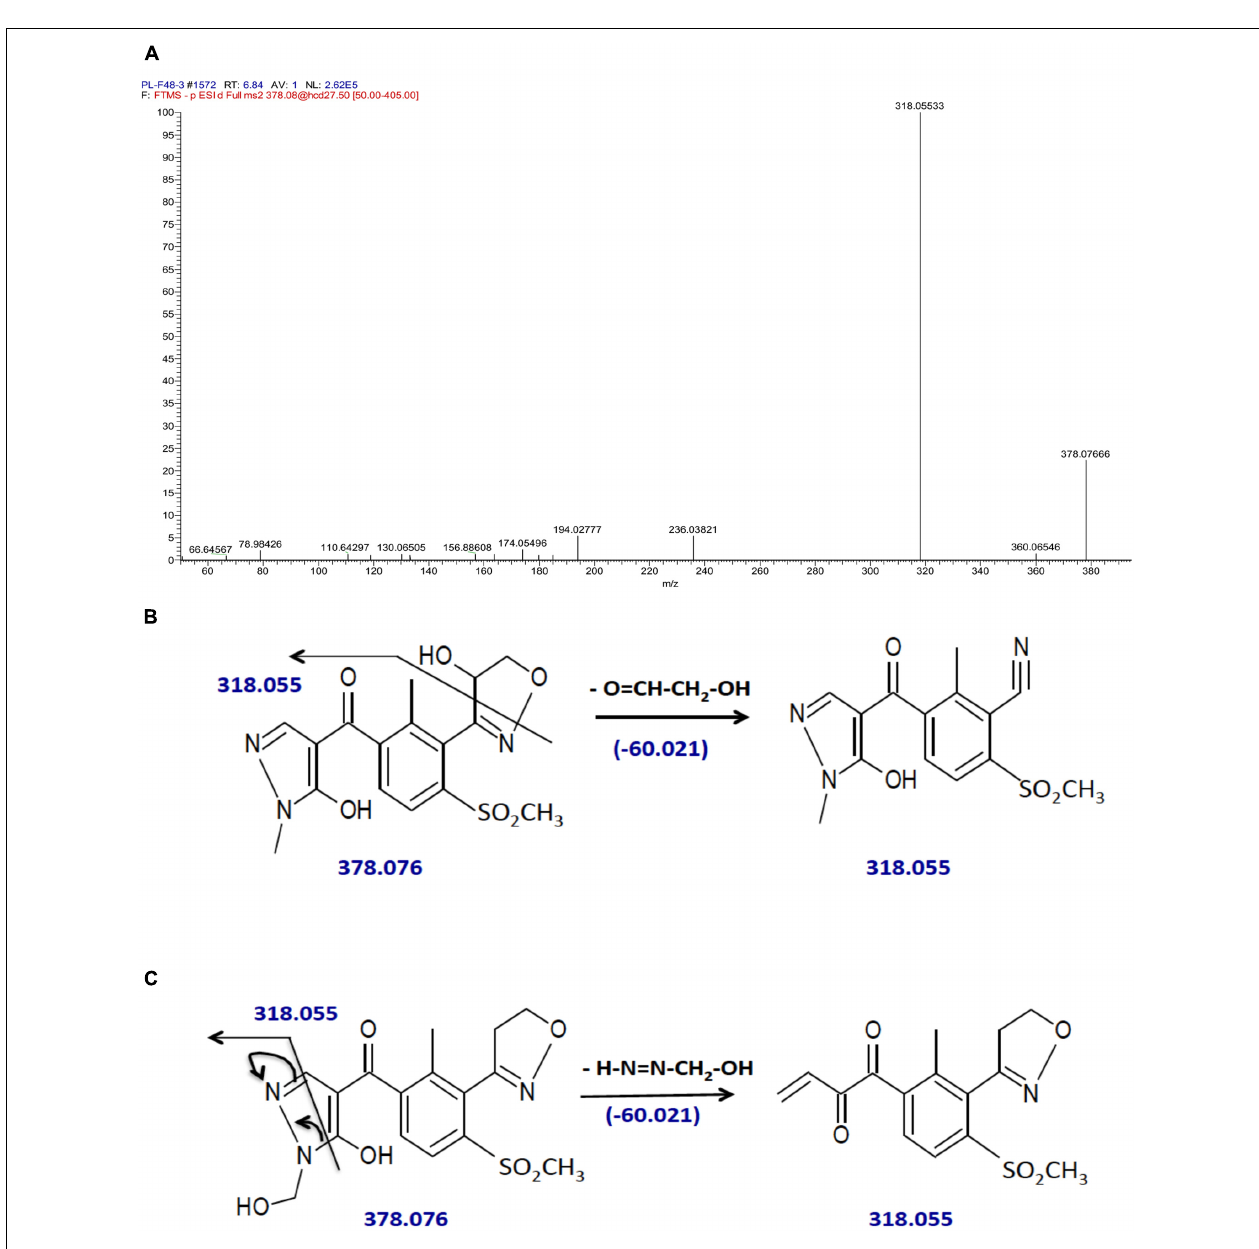
FIGURE 7 | Identification of hydroxytopramezone-2 metabolite formed in treated leaves of multiple herbicide-resistant waterhemp (SIR) 48 HAT using high-resolution LC-MS. The third- and fourth-youngest leaves from waterhemp and maize plants (10–12 cm tall) were treated with 60 × 0.33 µ L droplets (20 µ L total) of a 1.5 mM topramezone solution, including 0.1% (v/v) Tween 20 as a leaf wetting agent, using a glass syringe. Only the treated leaves were harvested from each plant (48 HAT), extracted and partially purified by SPE chromatography, then analyzed by LC-MS (high resolution) as described in Section “Materials and Methods.” (A) LC-MS/MS spectrum of hydroxytopramezone-2, indicating the stable fragment ion with m/z of 318.055. (B) LC-MS/MS fragmentation pattern and proposed daughter ion structures derived from the putative isoxazole ring hydroxylation metabolite. (C) LC-MS/MS fragmentation pattern and proposed daughter ion structures derived from the putative hemi-aminal (i.e., N- alkyl hydroxylation)